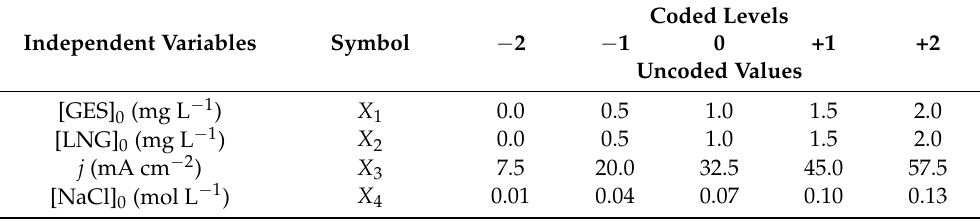
Table 3. Independent variables and their coded and uncoded